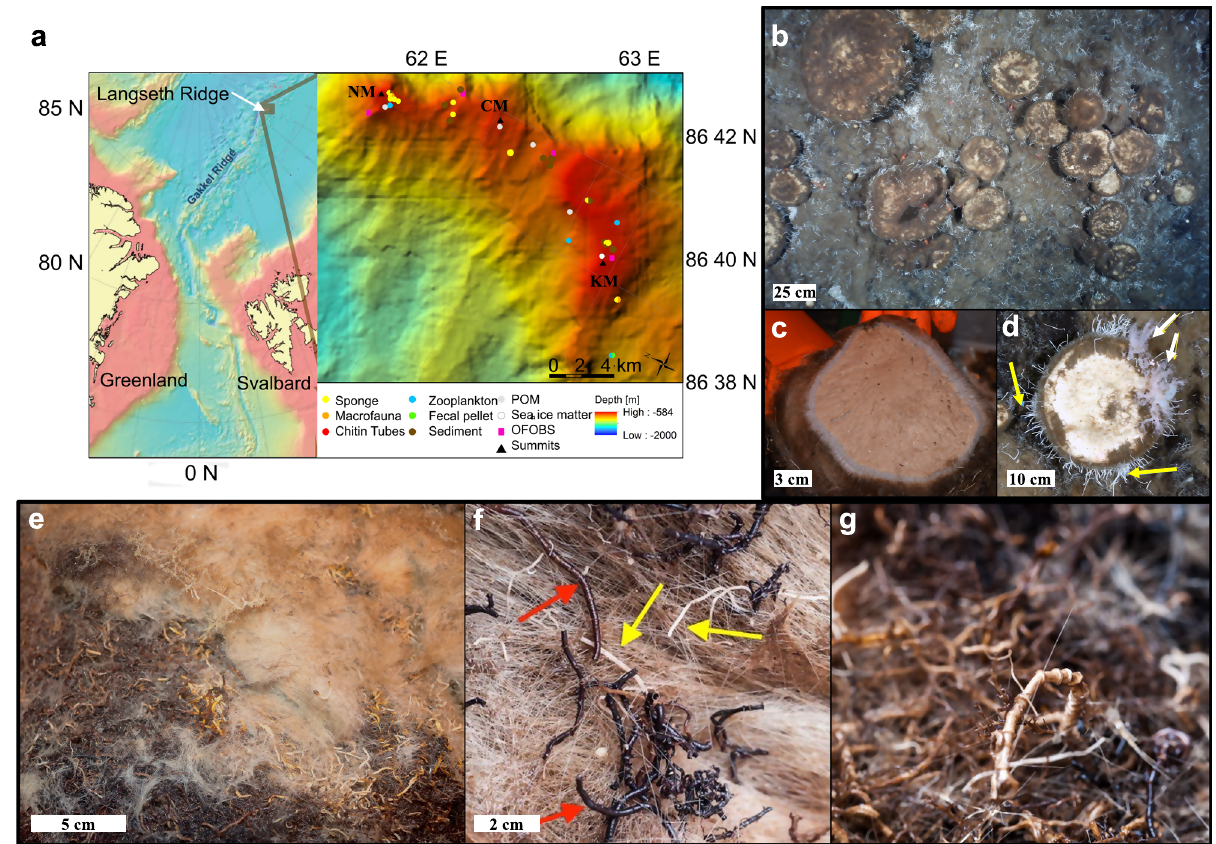
Fig. 1 Sponge ground landscape and features. a Map showing the study area in the Central Arctic and sample types collected at different sampling stations along the Langseth Ridge (NM Northern mount, CM central mount, KM Karasik seamount); b Arctic Geodia sponge ground (photo credits PS101 AWI OFOBS); c Geodia sp. pro fi le (photo credits Jennifer Dannheim); d Details of a sponge specimen colonized by several species of tube-dwelling polychaetes arranged radially from the equatorial area of the sponge (yellow arrows), and soft corals growing on a sponge (white arrows) (photo credits PS101 AWI OFOBS); e Detailed spicule-mat like structure: the light beige part is composed of sponge spicules, the dark brown part is composed of